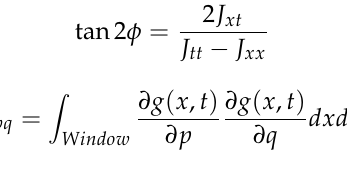
Figure 2. Space-time Image (STI): ( a ) original image; ( b ) 2D Fourier transform image.